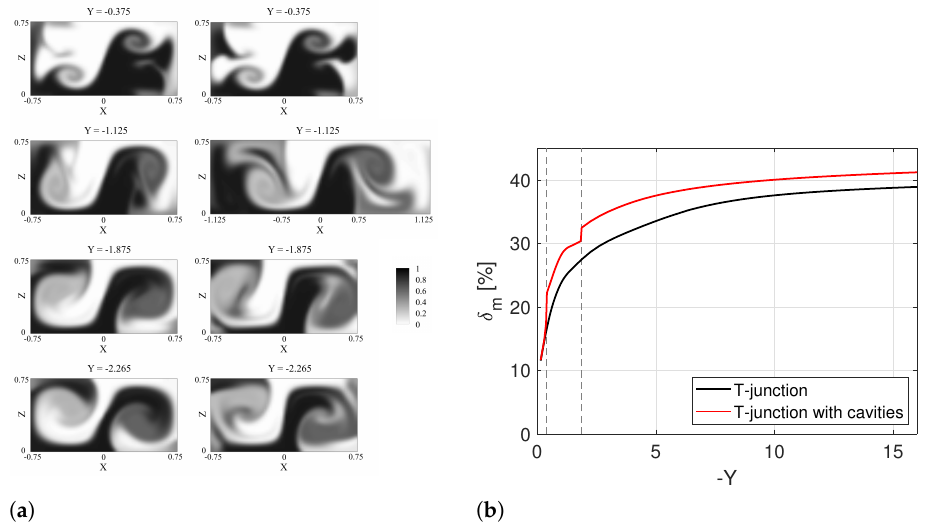
Figure 4. ( a ) Contours of non-dimensional dye concentration at the Y = − 0.375, − 1.125, − 1.875, and − 2.265 cross-sections along the outlet channel for the TJ case (left panel) and the TJC case (right panel) in numerical simulations at Re = 200. ( b ) Degree of mixing of the T-junction as a function of Y at Re =